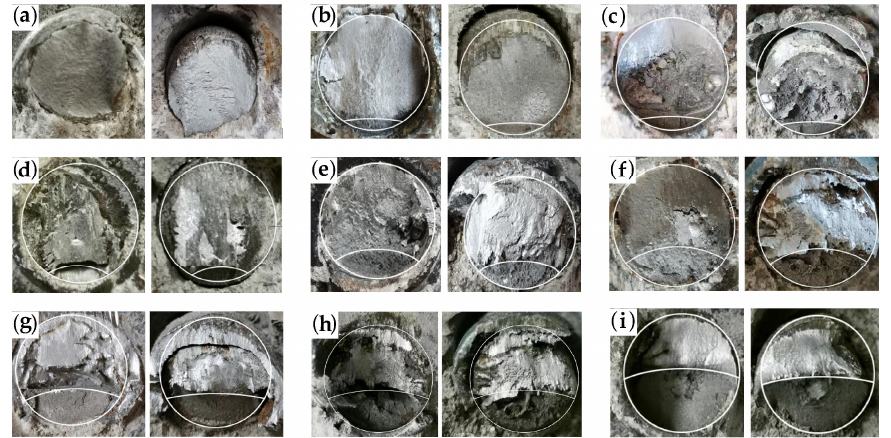
Figure 10. Cross-sectional characteristics of studs at different cyclic loads: ( a ) static damage; ( b ) specimen F-1; ( c ) specimen F-2; ( d ) specimen F-3; ( e ) specimen F-4; ( f ) specimen F-5; ( g ) specimen F-6; ( h ) specimen F-7; ( i ) specimen